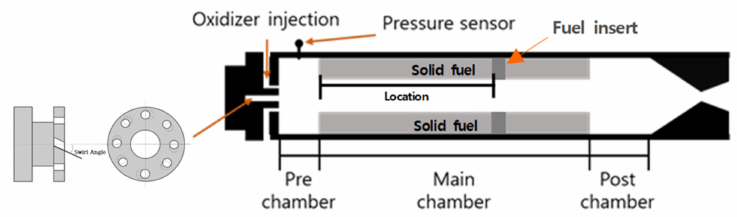
Figure 9. Schematic of combustion test setup.